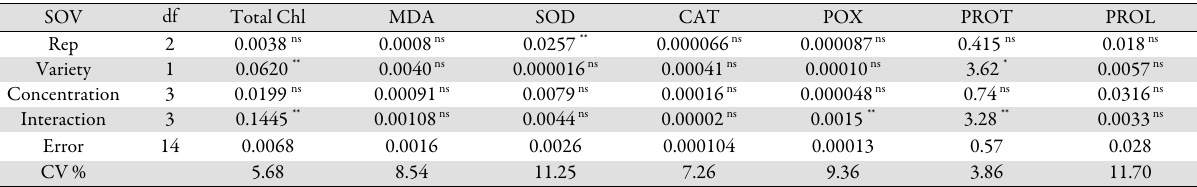
Table 1. Analysis of variance on total Chl, MDA, SOD, CAT,POX, protein and proline of canola genotypes, treated by SA in first day SOV df Total Chl